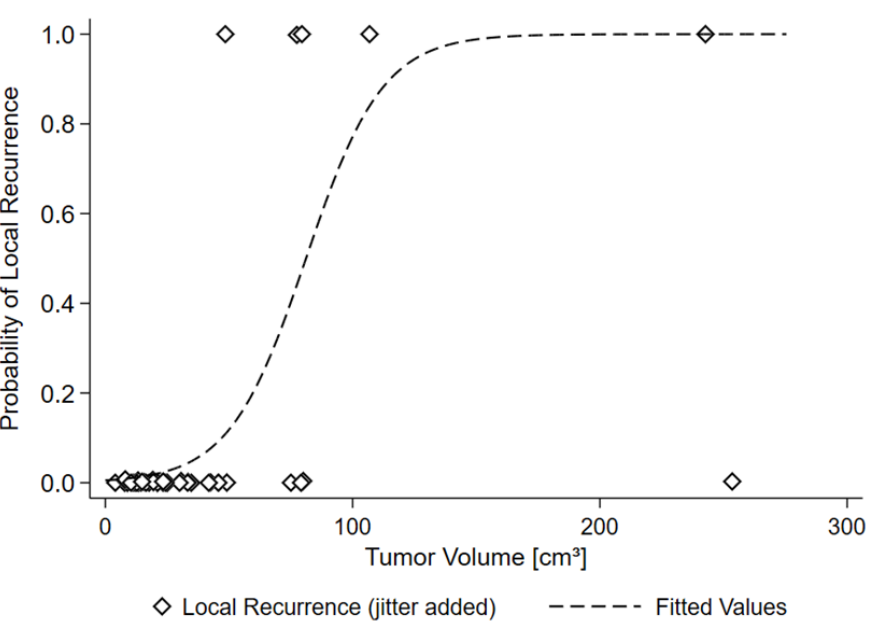
Figure 5. Relationship between tumor volume and local failure: tumor volume at time of particle therapy ≥ 50 cc was predictive of local failure. Graph depicts a non-linear model (sigmoid curve) for the relationship between tumor volume and local recurrence, p = 0.0097, p -value for logistic regression model for the association between volume and recurrence.